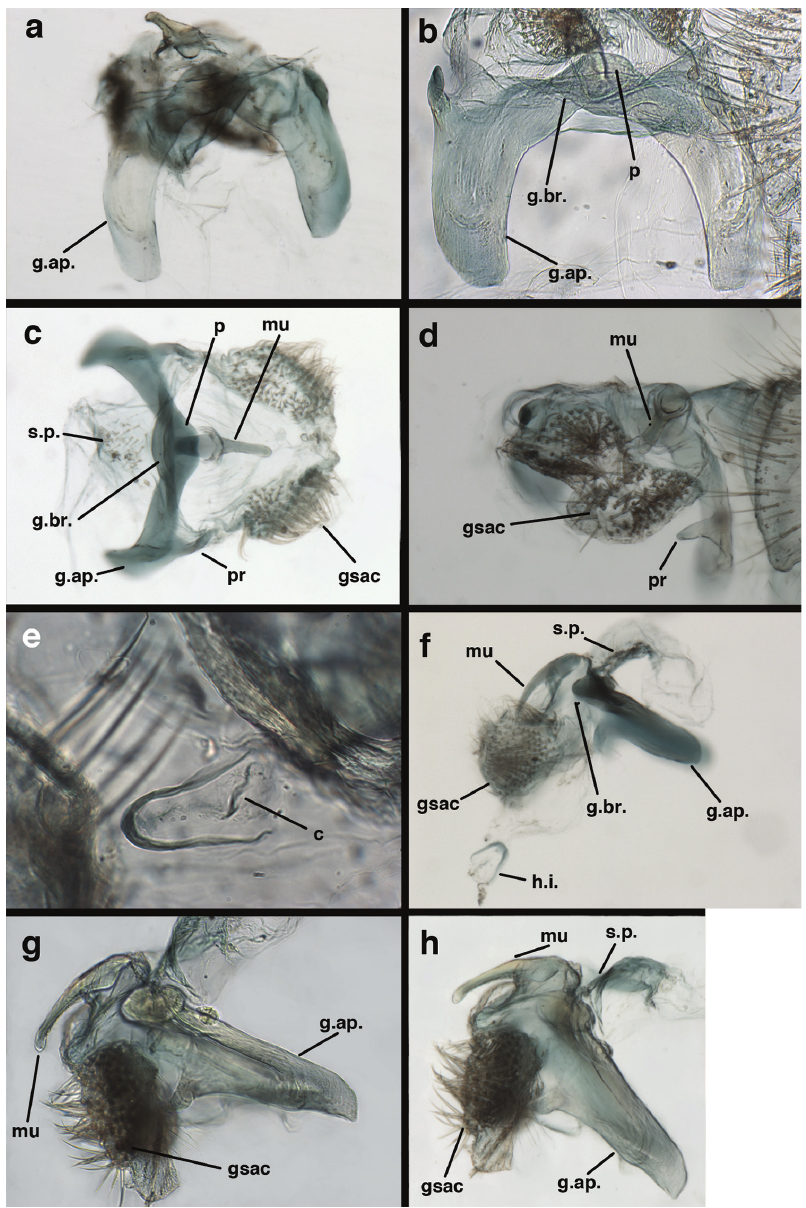
Figure 41. Ungla favrei (Navás): Male genitalia, ( a ) gonarcal complex, posterior, somewhat flattened ( b ) gonarcus, posterior ( c ) gonarcal complex, dorsal, gonosaccus fully expanded ( d ) gonarcal complex, frontal, tilted, gonosaccus partially expanded ( e ) hypandrium internum ( f ) gonarcal complex, lateral, gonosaccus fully expanded ( g, h ) gonarcal complex, lateral, gonosaccus partially expanded. c comes gsac gonosaccus g.ap. gonarcal apodeme g.br. gonarcal bridge h.i. hypandrium internum mu mediuncus p platform on mesal section of gonarcal bridge pr unarticulated process on frontal margin of gonarcal apodeme s.p. setose subanal plate (Bolivia, Cochabamba,